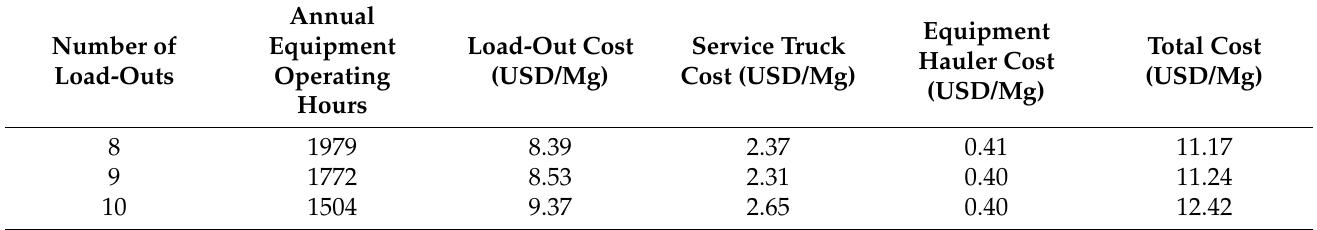
Table 6. Load-out cost (USD/Mg annual delivery) for the three load-out simulations.